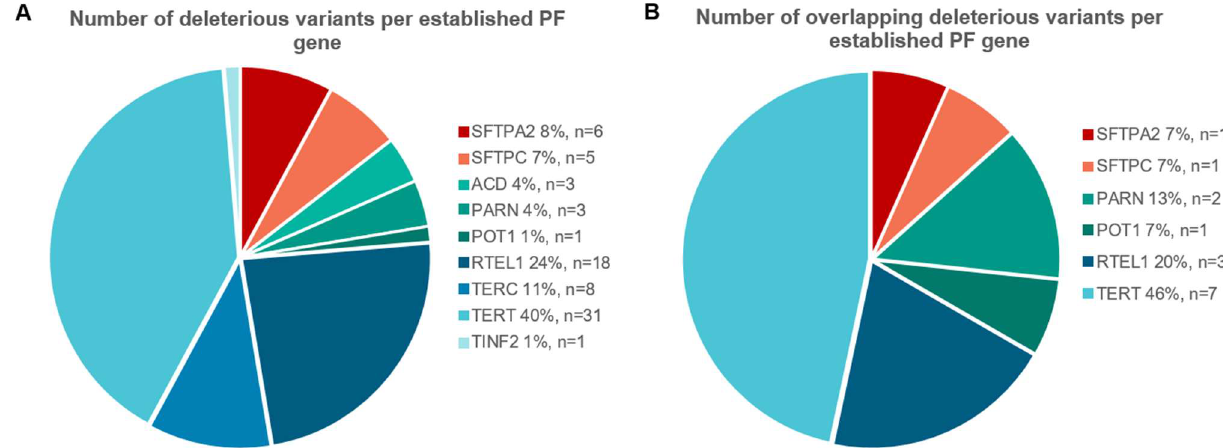
Figure 2. ( A ) Distribution of number of different variants per established dominant PF gene. A total of 65 out of 76 variants are observed in telomere related genes (blue/green), accounting for 85% of the variants in total. Eleven variants are located in surfactant related genes (red/orange); ( B ) Distribution of number of overlapping variants per established PF gene. Thirteen out of 15 variants involve telomere related genes, accounting for in total 87% of the observed overlap.